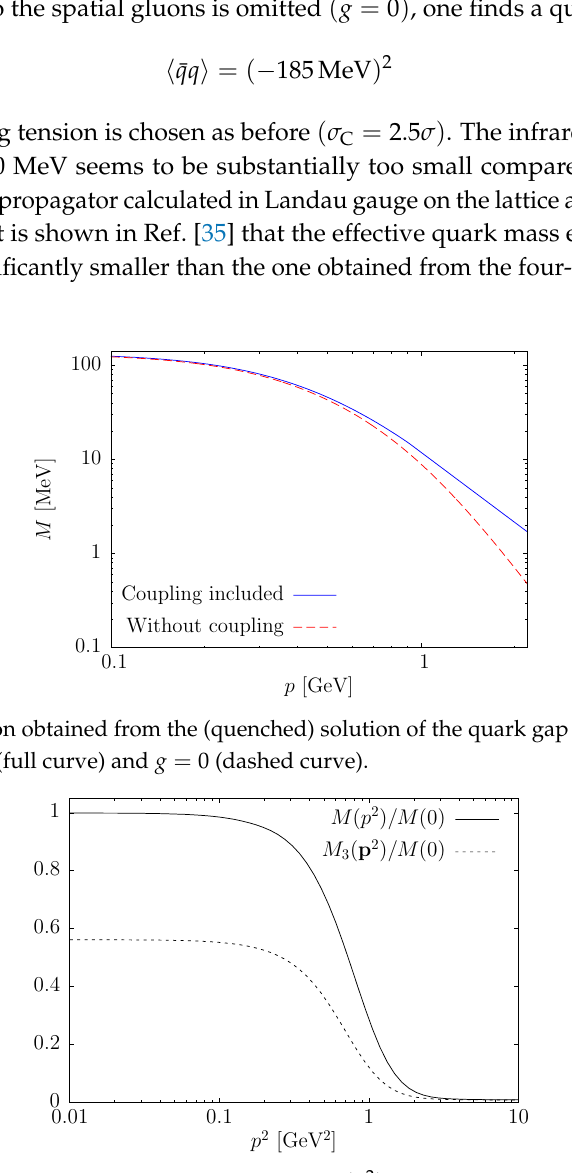
Figure 5. Comparison between the full mass function M ( p 2 ) in Landau gauge (continuous line) and the mass function M 3 ( p 2 ) of the equal-time propagator (dashed line) (see